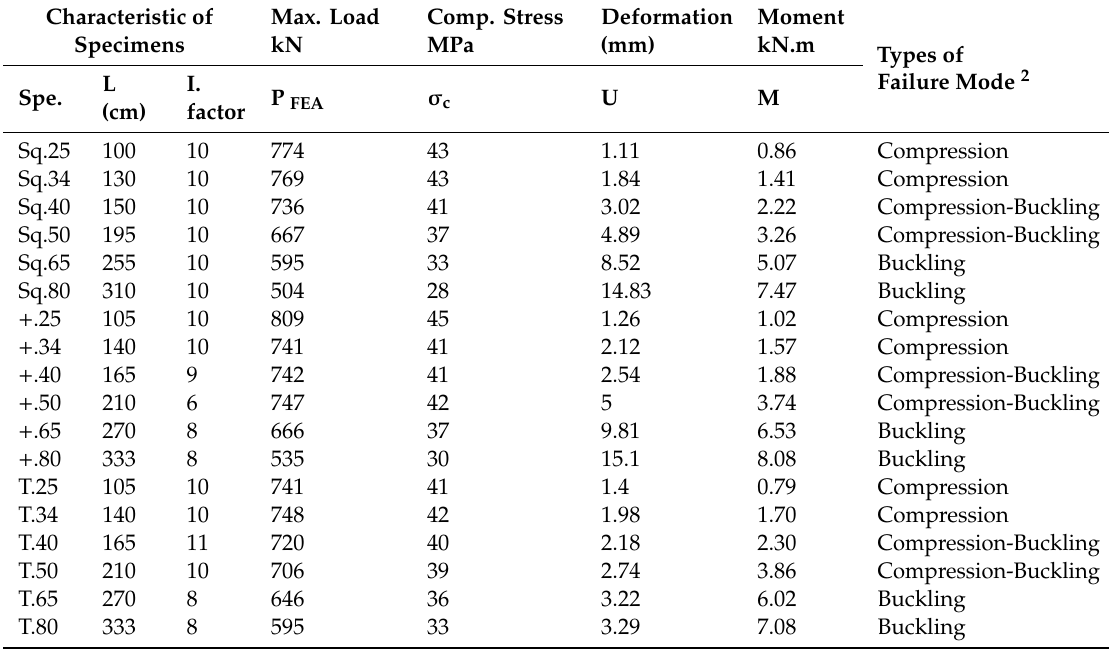
Table 3. FE results of specimens 1 .